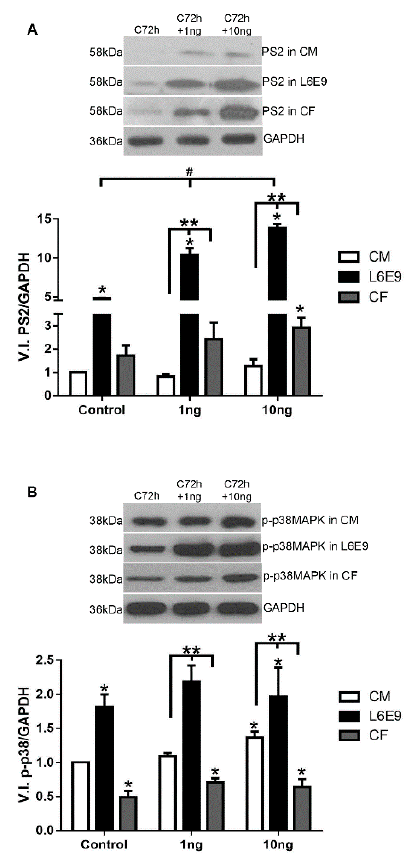
Figure 2. Phosphorylated SMAD2 and p38 MAPK detection in normal cultures. ( A ) Comparison of SMAD2 phosphorylation (PS2) detection of CM, L6E9 skeletal myoblasts, and CF treated with TGF- β (1–10 ng/mL) per 1 h. PS2 basal levels in L6E9 skeletal myoblasts and CF were significantly greater than CM. After the addition of TGF- β , PS2 remained significantly higher in L6E9 and CF relative to CM. L6E9 skeletal myoblasts responded to TGF- β stimulus in a dose dependent manner. CF showed a slight level of PS2 increase. * p ≤ 0.05 compared to CM; ** p ≤ 0.05 compared with CM in a different concentration; # p ≤ 0.05 compared with L6E9 control. N = 3; ( B ) Comparison of phosho-p38 MAPK detection of CM, L6E9 skeletal myoblasts, and CF treated with TGF- β (1–10ng/mL) per 1 h. L6E9 skeletal myoblasts presented a high level of p38 MAPK phosphorylation when compared with CM. When CM was compared with CF, a higher p38 MAPK phosphorylation after stimulation with TGF- β (1–10 ng/mL) was observed. * p ≤ 0.05 compared to CM and ** p ≤ 0.05 compared with CM in a different concentration. N = 3.